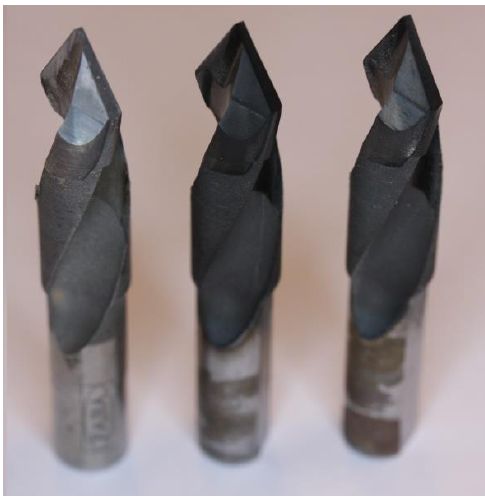
Figure 2. General view of the drill bits from all groups (from the left: Groups A, B, and C). Prior to their insertion in the deposition system, the tools were cleaned in an ultra-sonic bath and dried using hot air. The magnetron sputter deposition system CC800/9 sinOx ML (CC9, Cemecon, Würselen, Germany) was used for the deposition of both nanolayer “nl-AlTiN/TiN” and double-layer “TiAlN/a-CN” hard coatings. In this system, the chamber is equipped with four rectangular magnetron sputtering cathodes (500 × 88 mm), which operate in DC. Target configurations for the deposition of both coatings are presented in Figures 3 and 4. Three “AlTi” and one “Ti” target were used in order to prepare the “nl - AlTiN/TiN” coating. During the deposition of the “AlTiN” coating , only the “AlTi” targets were active, while during the deposition of “TiN” only one “Ti” target was active. In order to achieve a nanolayer structure, the substrates were positioned on the two- fold rotation mounting at the planetary substrate holding system. The “nl - AlTiN/TiN” coating is composed of about 200 individual layers of “AlTiN” and “TiN”. Three “TiAl” and one pyrolytic graphite target were used to prepare the “TiAlN/a - CN” coating. During the deposition of the “TiAlN” coating, only the “TiAl” targets were active, while during the deposition of “a - CN” , only one graphite target was active. Prior to the deposition, the chamber was evacuated to a base pressure of 3 mPa, and heated to around 450 °C. In the next step, the substrates were ion-etched for 15 min in a mid-frequency plasma (Ar and Kr gas mixture, 240 kHz, duty cycle 1600 ns), with a bias voltage of 650 V, applied to the substrate table. MF etching was followed by so-called «booster» etching, where the working gas is injected through upper and lower “booster” etch nozzles (i.e., the hollow cathode), where intensive ionization of the working gas (Ar, Kr) occurs. Such additional discharge enhances the plasma density and thus the intensity of the etching process. Coatings were deposited in a mixture of argon (160 mL/min), krypton (110 mL/min), and nitrogen (80 mL/min) at a total pressure of 0.66 Pa. The total thickness of this multilayer coating is about 4 μm.